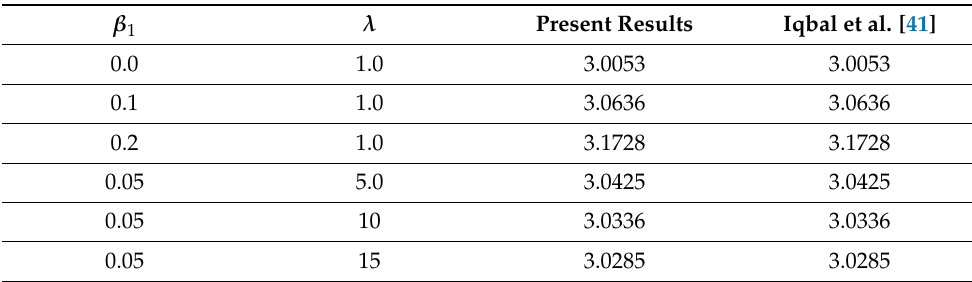
Table 6. A comparison of the present results of Nu x against β and λ with those of Iqbal et al. [41] when Br = λ 1 = δ = 0, ϕ 1 = 0.1 and ϕ 2 = 0.